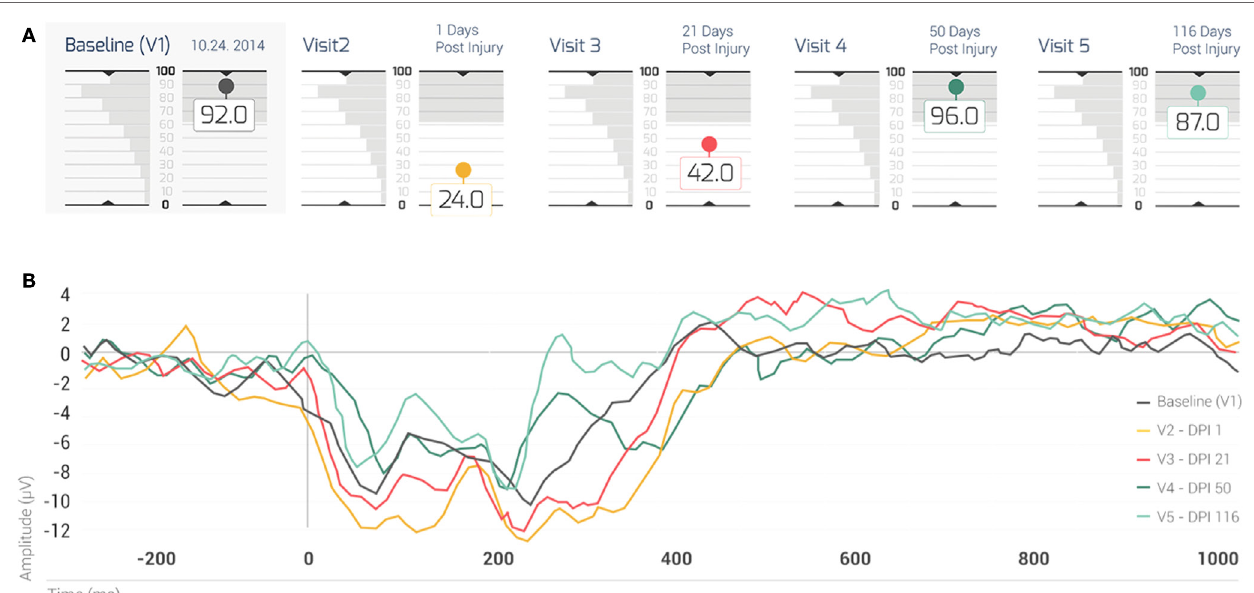
FIGURe 2 | (a) The BNA scores of the case for his five visits. The shaded box indicates the test–retest 1 SD of the change between two visits, for a group of 41 normal healthy subjects (i.e., the normal range of change). Note that his BNA scores for visits 2 and 3 (1 and 21 days post concussion, respectively) fall outside of the normal range of change. Each visit is color coded: baseline (visit 1): black; visit 2: brown; visit 3: red; visit 4: dark green; and visit 5: light green. (B) The case’s ERP grand average waveforms recorded at the AFz channel. Note that each waveform is associated with a different visit (visits 1–5, respectively) and that the waveforms were color coded in the same manner as the visits in (TOP). EDI = elapsed days from injury; V =